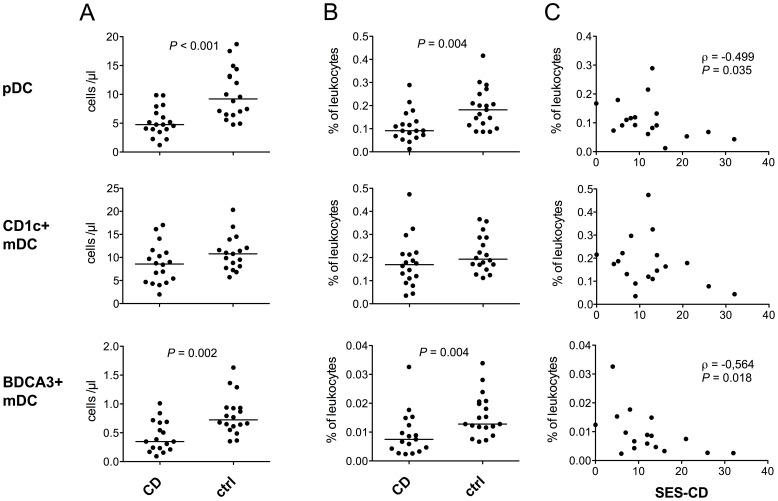
Patients with Crohn’s disease have reduced numbers of pDCs and BDCA3+ mDCs in the peripheral blood.Both absolute (A) and relative (B) pDC and BDCA3+ mDC counts are decreased in CD. The major blood myeloid DC population expressing CD1c is not significantly different from controls in size. Horizontal lines indicate median levels. Statistically significant negative correlations between the total SES-CD score and relative pDC and BDCA3+ mDC counts are observed in CD patients (C).